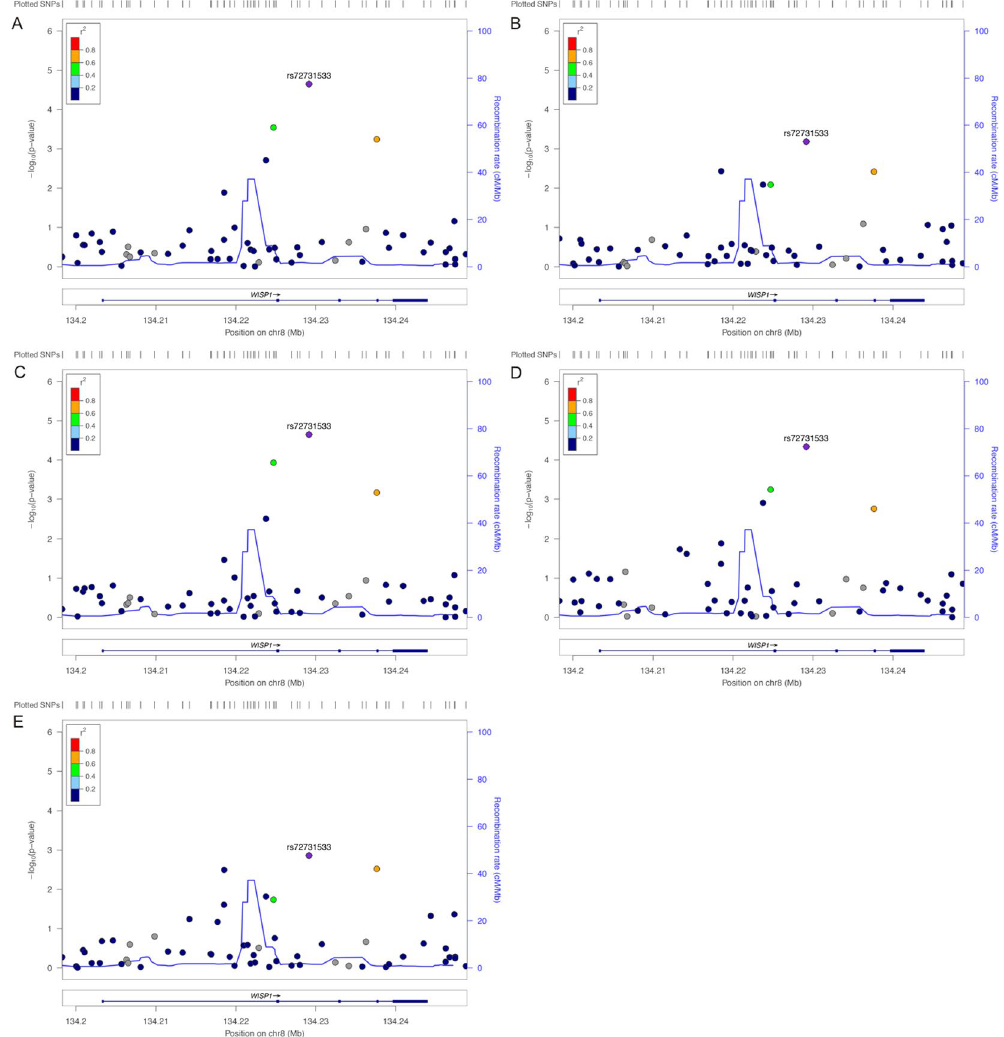
Figure 1. Regional association plots for the WISP1 ( + / − 5 kb) region for BMD in ( A ) total hip, ( B ) femoral neck, ( C ) hip intertrochanter, ( D ) hip trochanter and ( E ) lumbar spine. Genetic variants in and around the WISP1 gene ( + / − 5 kb) are depicted on x axis, and the corresponding association p value ( − log10) on y axis. The top SNP, i.e. rs72731533, is denoted by a purple color. Variants are color coded according to their LD (r 2